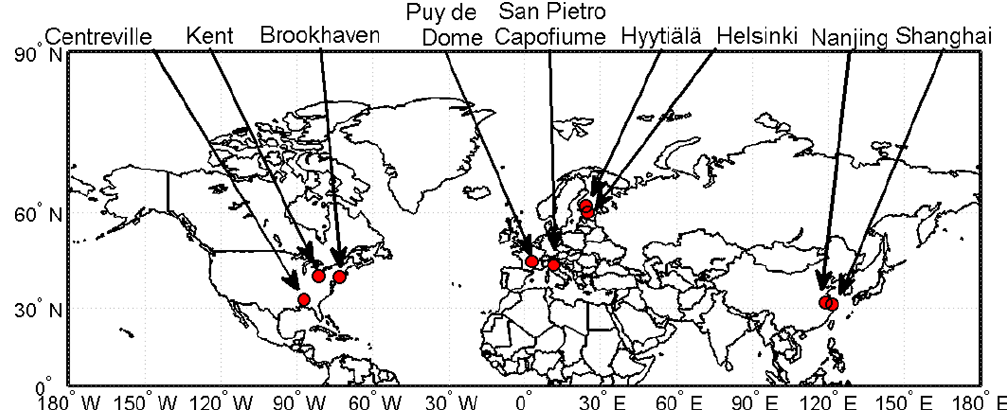
Figure 1. A map showing the locations of the measurements sites. Table 1. Overview of the measurements analyzed in this